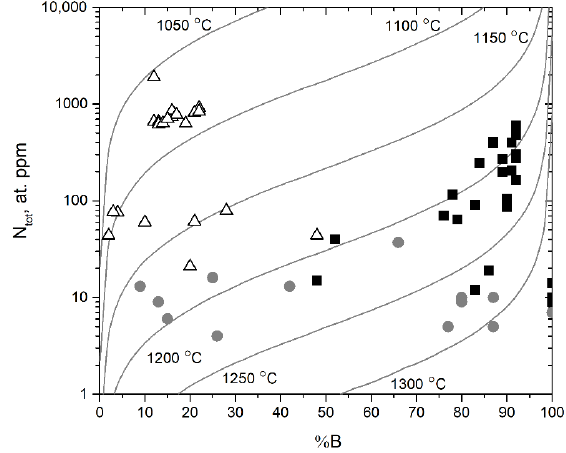
Figure 3. Nitrogen aggregation state (% B) vs. total nitrogen content (N total ) for our collection of Mir diamonds. Isotherms for 1050–1300 °C and diamond mantle residence time of 3 Ga are based on Taylor et al. [26]. The triangles, squares, and circles reflect the division of diamonds into type IaAB, type IaB, and type IIa, respectively. Each point corresponds to the measured IR spectrum.